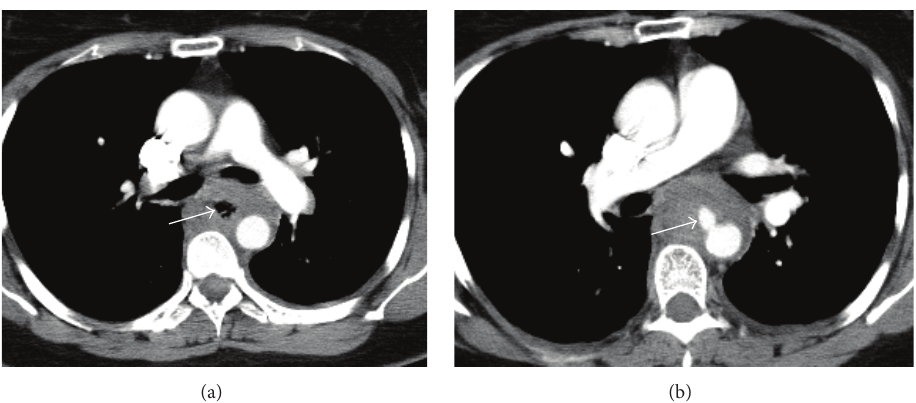
Figure 1: (a) Axial enhanced CT scan. Mediastinal collection with air bubbles within it (white arrow). (b) Axial contrast enhanced CT scan. Pseudoaneurysm of the thoracic aorta (white arrow).